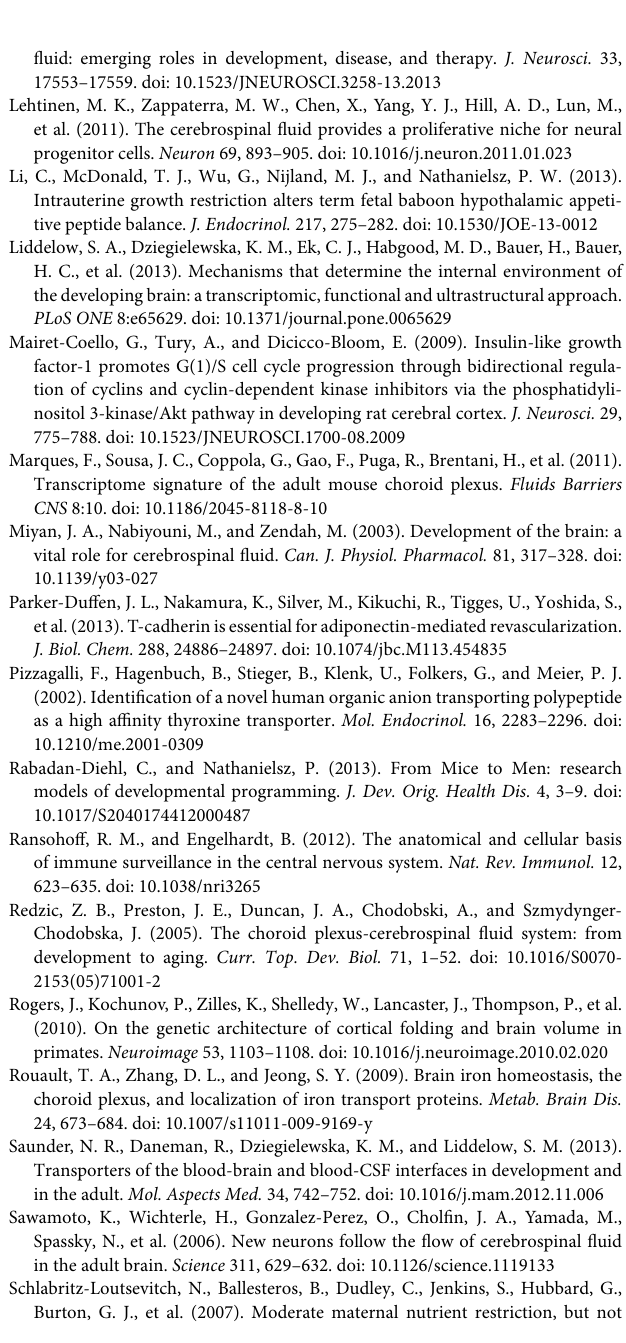
Supplementary Figure 3 | Example of molecular activity prediction using Ingenuity Pathway Analysis software for canonical Actin signaling pathway from differentially expressed genes between GD90 and GD165. This connects the gene changes in the actin signaling pathway to biological functions. The changes to this pathway predict an increase in actin polymerization and actin stabilization whereas actin reorganization is decreased. Supplementary Table 1 | Function annotated genes to all subcategory functions with a significant activation z-score ( > + 2 or < − 2). #, Number of annotated genes to